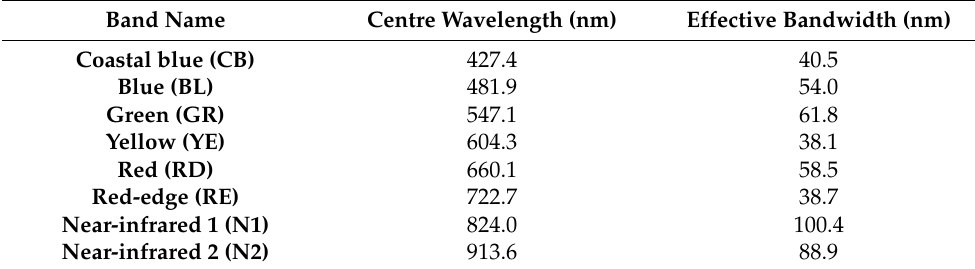
Table 2. WorldView-3 multispectral image (cid:48) s bands and their effective bandwidths